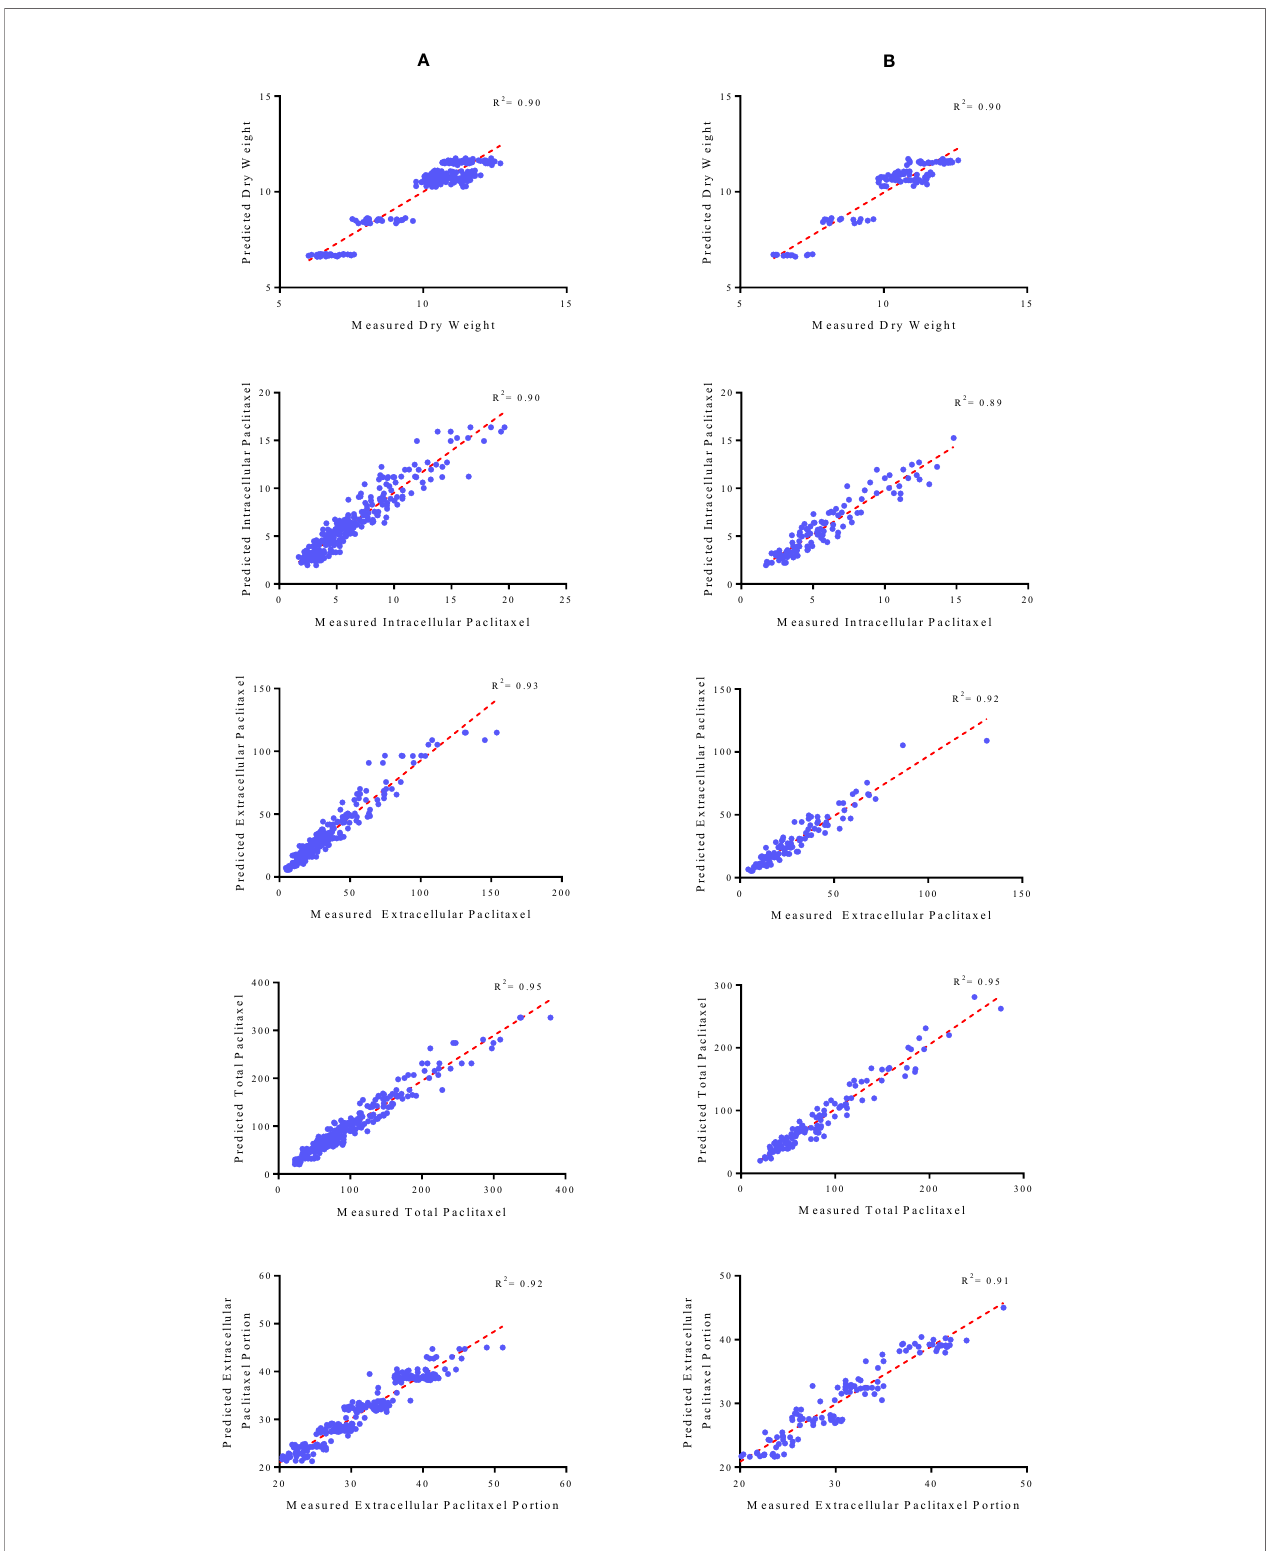
FIGURE 4 | Scatter plot of actual data against predicted values of dry weight, intracellular, extracellular and total yield of paclitaxel and extracellular paclitaxel portion in Corylus avellana cell cultures using multilayer perceptron-genetics algorithm (MLP-GA) models in training (A) and testing (B) subsets. The solid line shows fi tted simple regression line on scatter